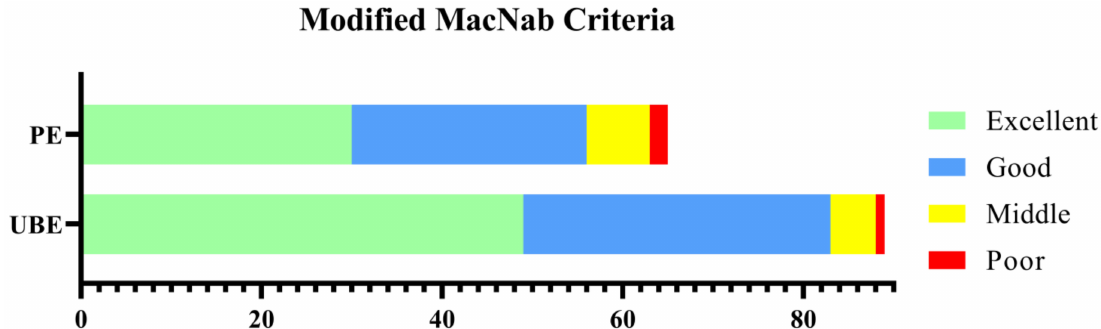
Figure 9. Evaluation of the outcome using modified MacNab